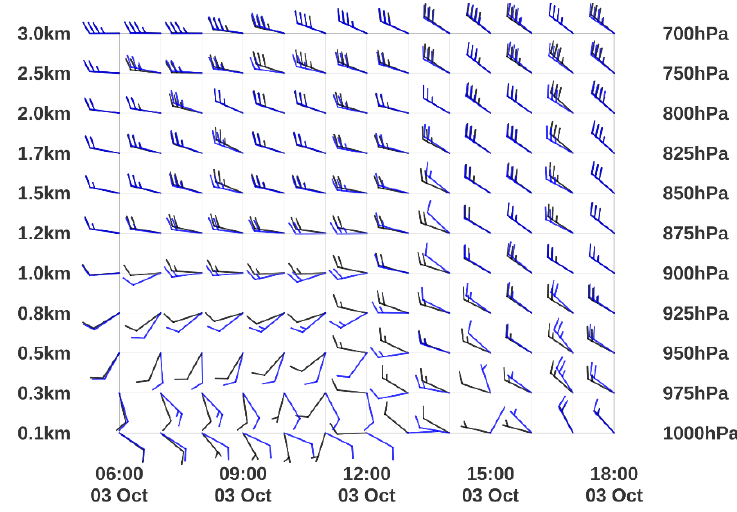
Figure 13. Forecast on 3 October 2018 06:00 UTC of temporal evolution of winds in a 0–3 km layer near Michalovce (same point as Figure 4) based on OPM (black wind barbs) and ELAM (blue wind barbs).